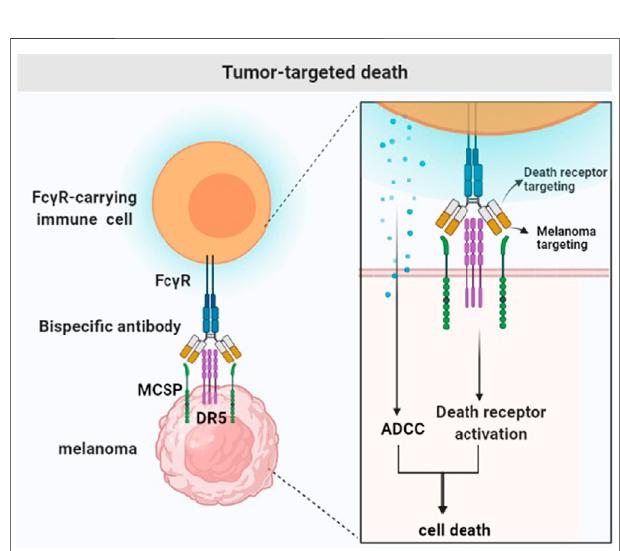
FIGURE 2 | Tumor-targeted death. Tumor drug resistance is due to the prevention of the initiation or execution of the cell death signal. Bispeci fi c antibodies bind to the tumor-speci fi c antigen (MCSP) to activate the death signaling pathway (DR5) and Fc γ R-carrying immune cells. L1 antibody may exert a cytotoxic effect, reverse the immune suppression in the tumor environment, and reduce side effects (Zhang et al., 2019) ( Figure 1 ).